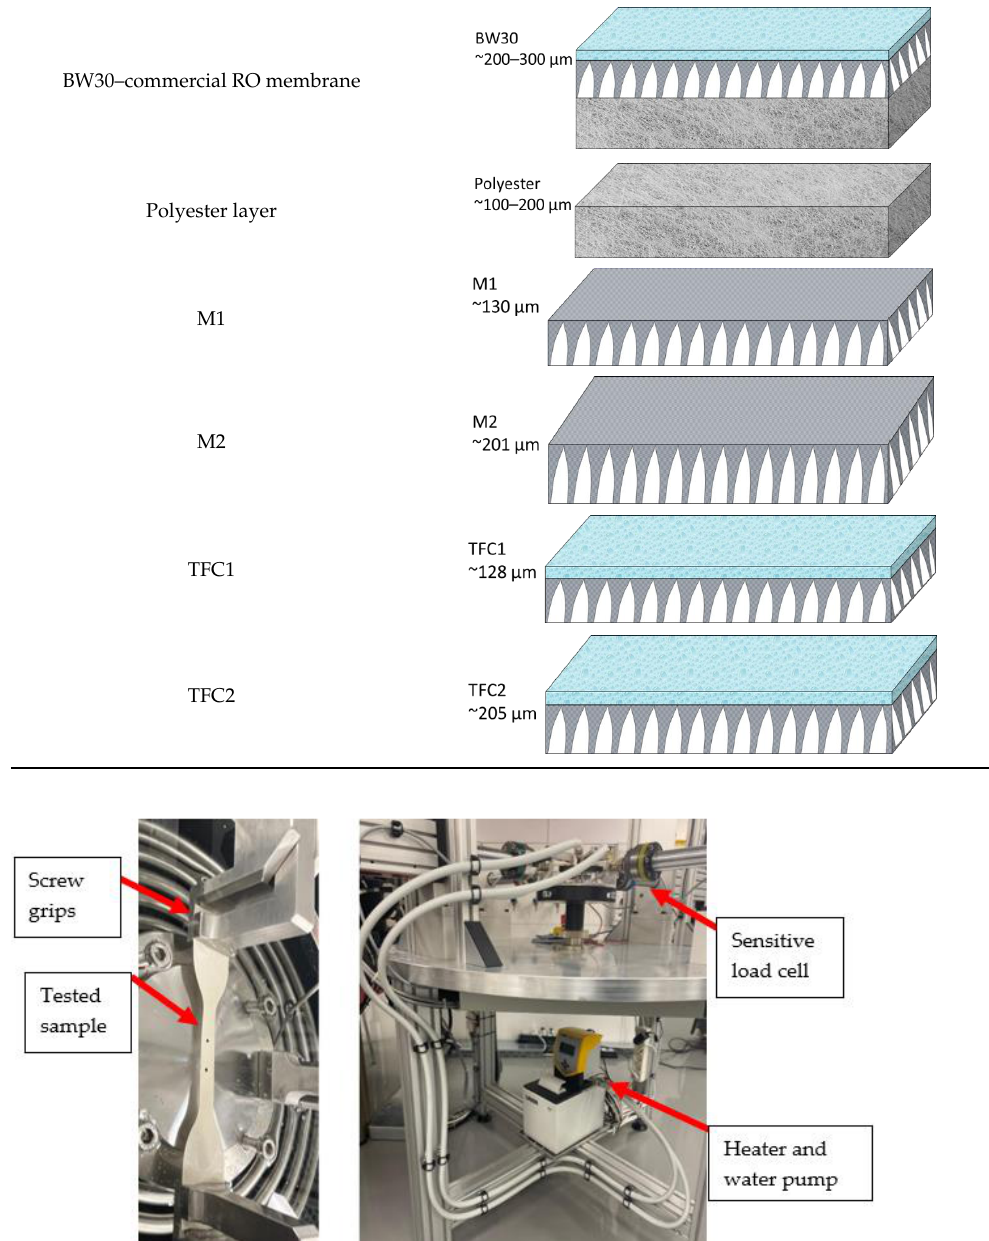
Figure 3. Tensile sample: ( a ) dimensions (mm) and ( b ) different cutting angle orienta- tions. In this investigation, a ZwickRoell customized uniaxial testing equipment was used to conduct the tensile testing, which is specifically intended to be employed in testing thin films. The electromechanical actuators provide a maximum displacement of 200 mm for each axis and a maximum speed of 10 mm/s. One-sided closing screw grips with 300 N F max are included with each actuator, in addition to a 2 kN load cell designed to measure static and dynamic tensile and compression forces. A laserXtens/VideoXtens compact de- vice from Messphysik is mounted on the top, with one uEye camera and an f = 75 mm objective lens, with an attached adjustable LED incident light for the illumination of the specimen. The videoXtens mode was used in this research, where the system measured the displacement of two marks (targets) on the specimen, either dry or through the liquid.